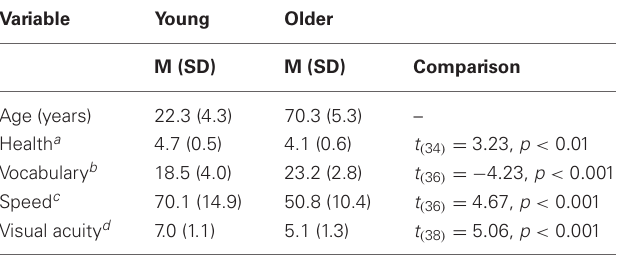
missing for two young and two older participants. b Vocabulary from the multiple choice section of the Mill Hill vocabulary test (Raven et al., 1988); maximum score = 33; data missing for two young participants. c Processing speed based on the Digit Symbol Substitution task (Wechsler, 1981); data missing for two young participants. d Visual acuity as measured by the number of lines read correctly from the Near Vision Test Card (Schneider, 2002) viewed at a distance of 16 inches whilst wearing corrective glasses, with scores ranging from 1 (16/160—lowest acuity) to 9 (16/16—highest